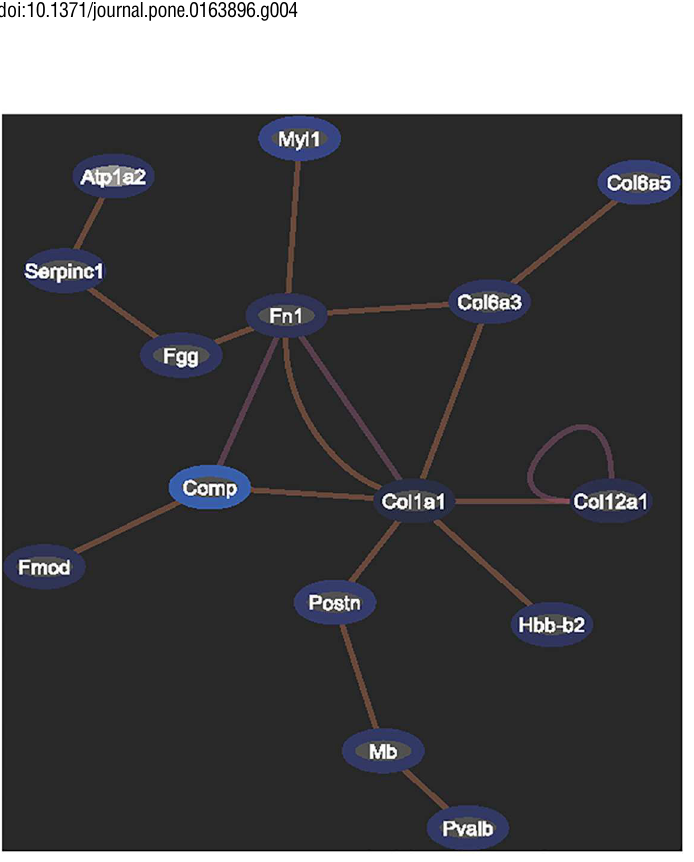
Fig 5. Network analysis of differentially expressedproteins with changes of 2.0-fold or greater in the cells irradiated by 2 Gy of carbon-ion radiation, with an LET of 12.6 keV/ μ